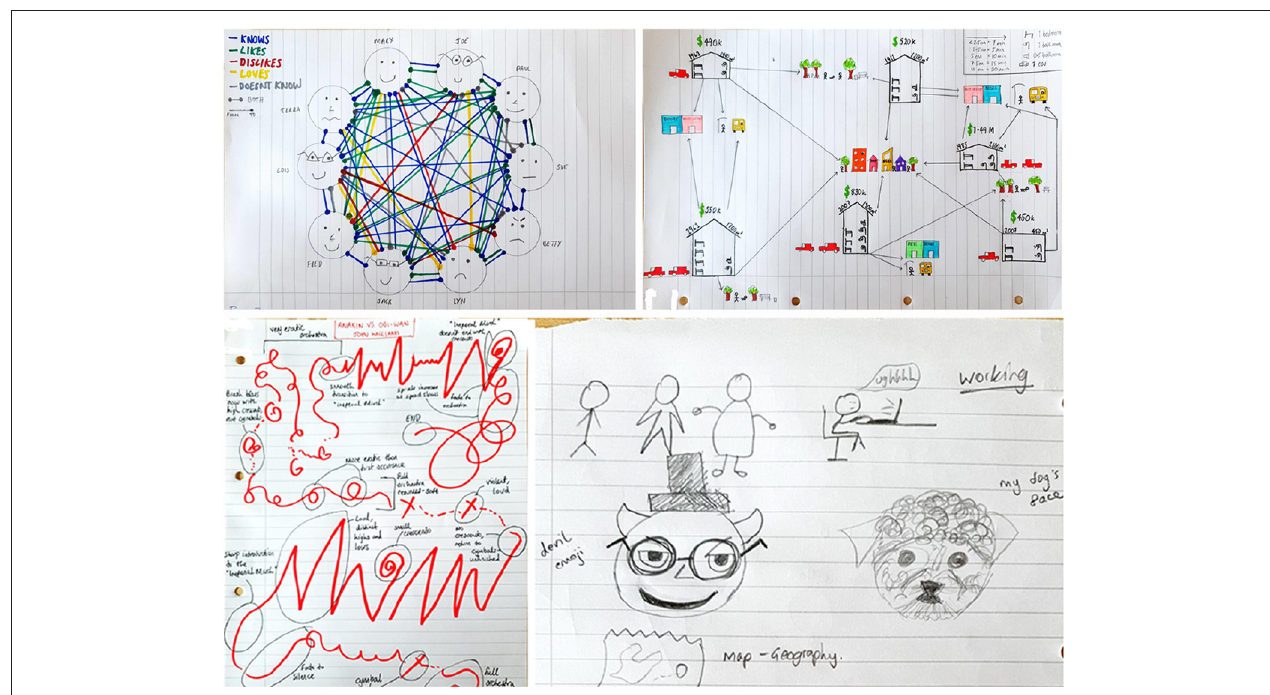
FIGURE 1 | From top-left to bottom-right, social network data-sketch, houses data-sketch, music visualization, emoji and figure practice. Reproduced with permission Oliver King,